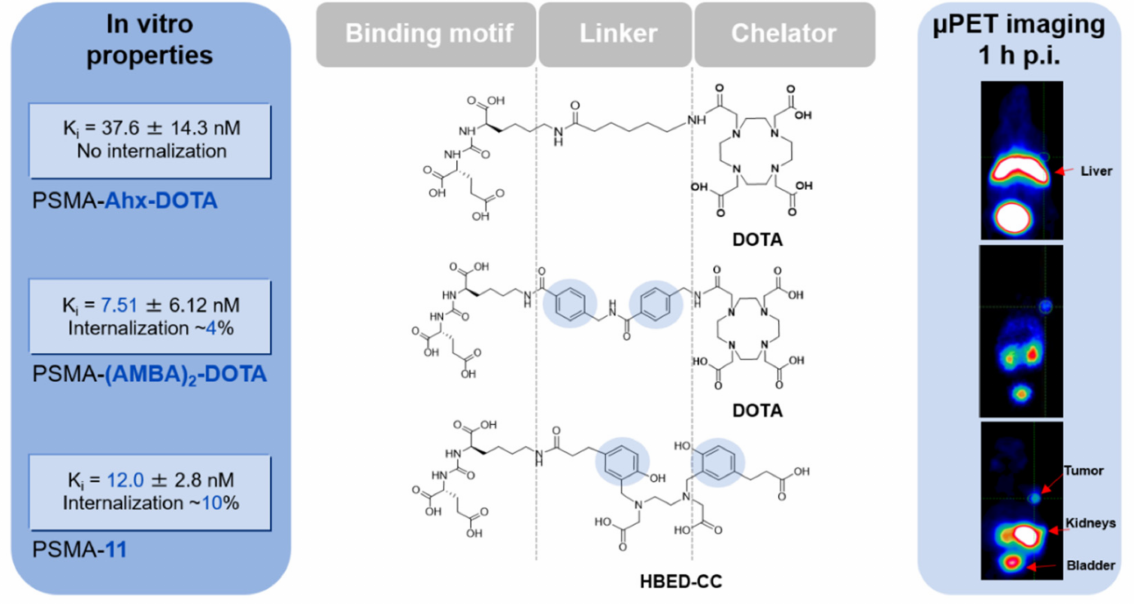
Figure 1. The pharmacokinetic and binding properties of 68 Ga-labeled PSMA targeting urea-based inhibitors are clearly affected by the exact composition of the linker and the presence of aromatic moieties. In case the linker is entirely aliphatic (PSMA-Ahx-DOTA), the affinity and internalization are low or lost, respectively, and the tracer is mainly localized in the liver without any detectable signal in the tumor. By introducing aromatic moieties in the linker region as represented by PSMA-(AMBA) 2 -DOTA, the compound exhibits better affinity and starts to show significant internalization of the tracer in the tumor cell, resulting in a visible tumor uptake and a changed PK profile. One of the unique characteristics of PSMA-11 is that the chelator HBED-CC takes over these functional requirements by its aromatic moieties and, therefore, interacts well with the binding pocket, resulting in a promising in vivo performance of the entire molecule. Data were obtained from previously published studies using LNCaP cells for the determination of affinity and internalization and LNCaP-tumor-bearing BALB/c nu/nu mice for PET imaging